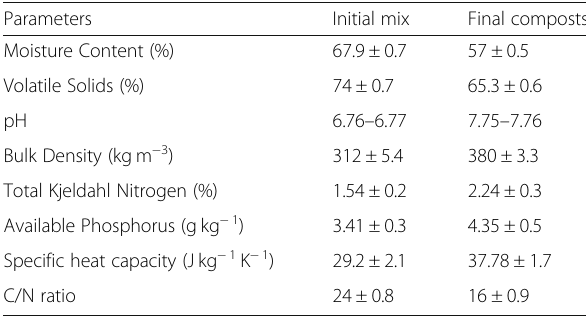
Table 2 The value of compost properties summarized at initial and final experimental periods Parameters